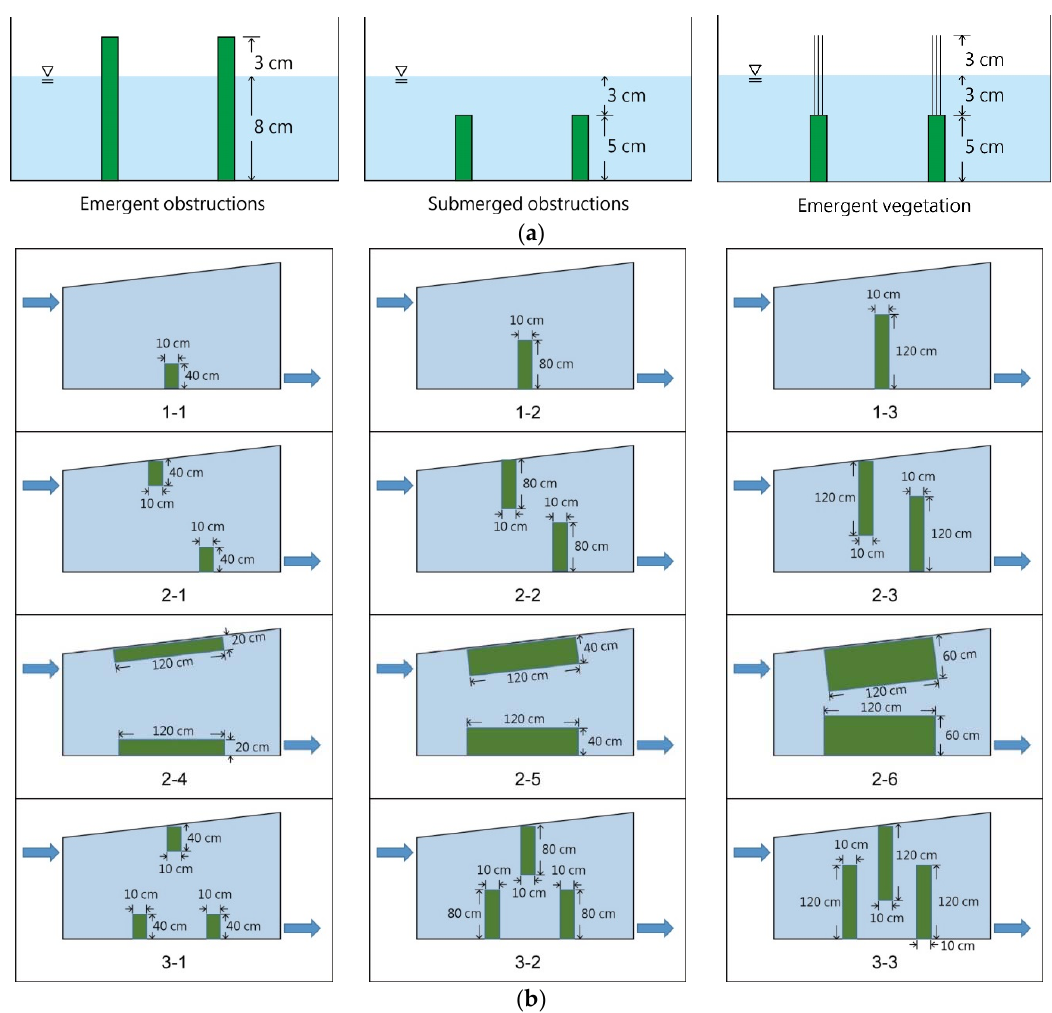
Figure 2. ( a ) Sizes and placement of emergent obstructions (EOs), submerged obstructions (SOs), and high ‐ and low ‐ density emergent vegetation (EV) in the side view. The heights of the EOs and SOs are 11 cm and 5 cm, respectively, which yield a protrusion and submergence of 3 cm above and below the water surface, respectively. The emergent vegetation was erected on the SOs and protruded above the water surface; and ( b ) configuration and dimensions of obstructions. In cases 2 ‐ 4, 2 ‐ 5, and 2 ‐ 6 (high aspect ratio), the obstructions were 120 cm long by 20–60 cm wide. In the other cases (low aspect ratio), the obstructions were 40–120 cm long by 10 cm